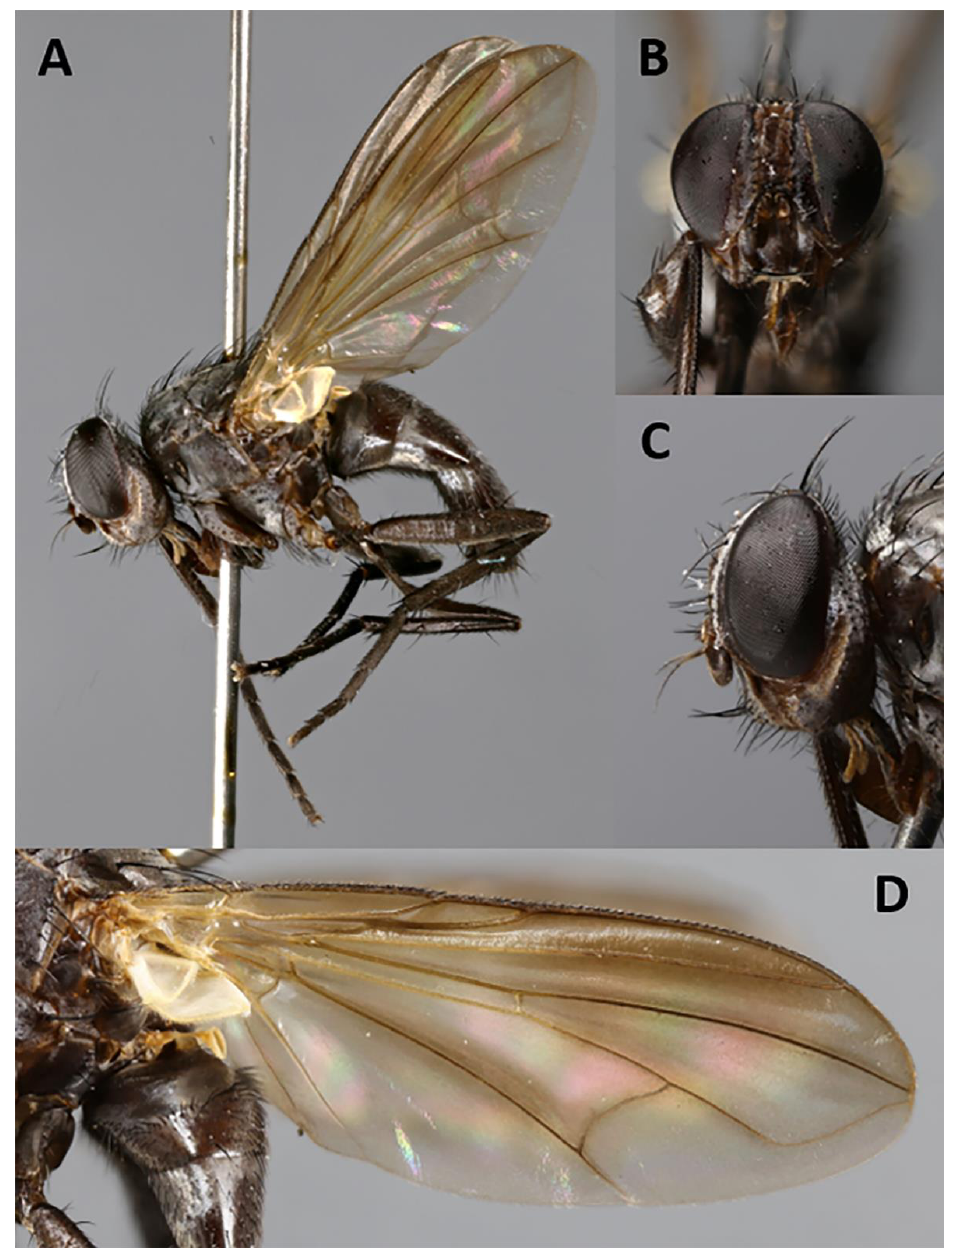
Figure 6. Baniassa pennata sp. nov. (paratype ♀ , BLKU). ( A ) Habitus in lateral view; ( B ) head in frontal view; ( C ) head in lateral view; ( D ) left wing in ventral view.